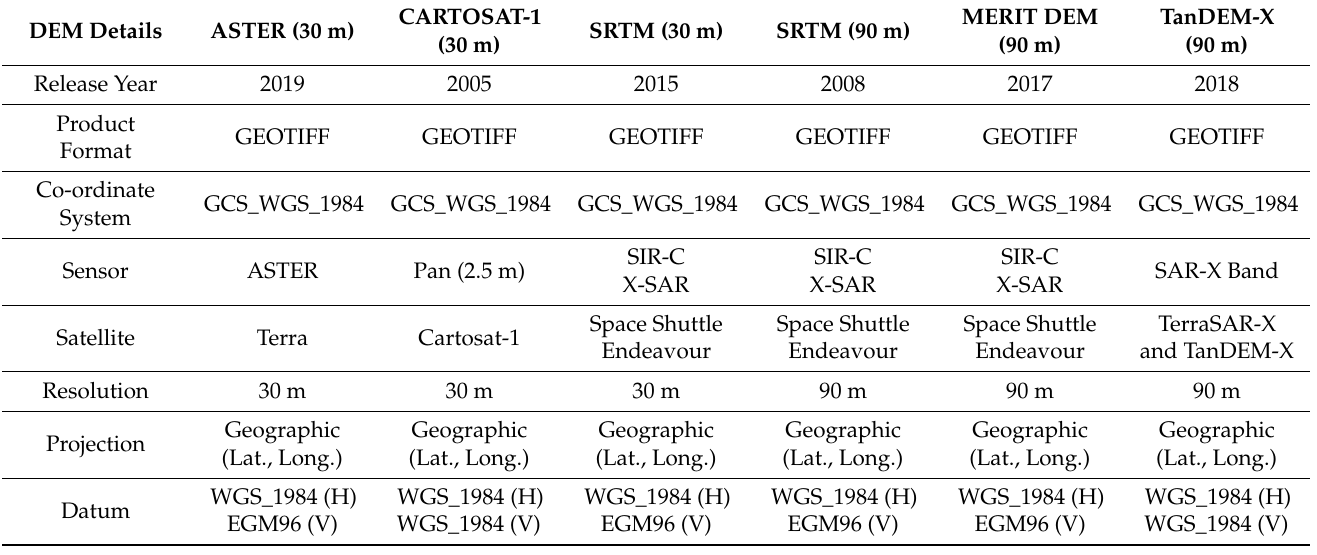
Table 2. Details of space borne elevation (DEM) data